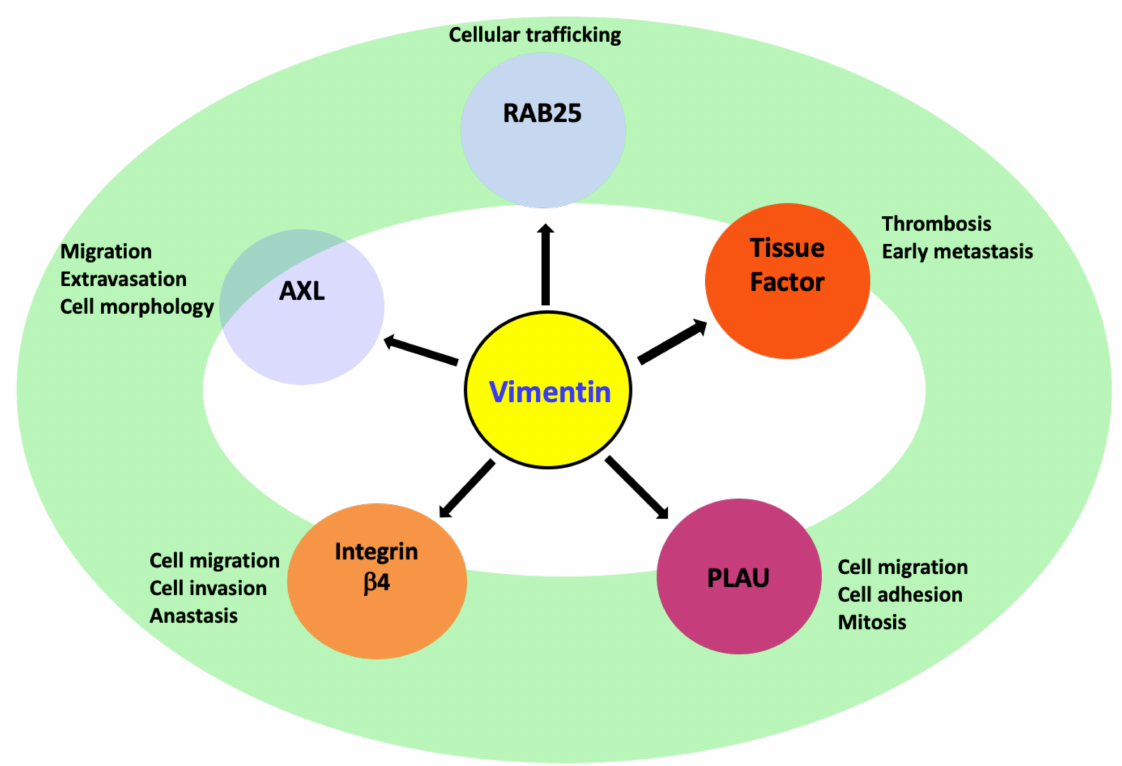
Figure 4. Vimentin supports cell migration and early cancer invasion by transcriptional regulation of different genes and activating multiple signalling pathways, such as RAB25-mediated AKT/GSK-3 β /Snail-signalling, pro-migratory enzyme AXL-mediated ERK signalling, integrin β 4-mediated PI3K/AKT/MAPK-signalling and PLAU /ERK1/2/PI3K-signalling or PLAU-mediated TGF- β 1/MMPs genes transcriptional